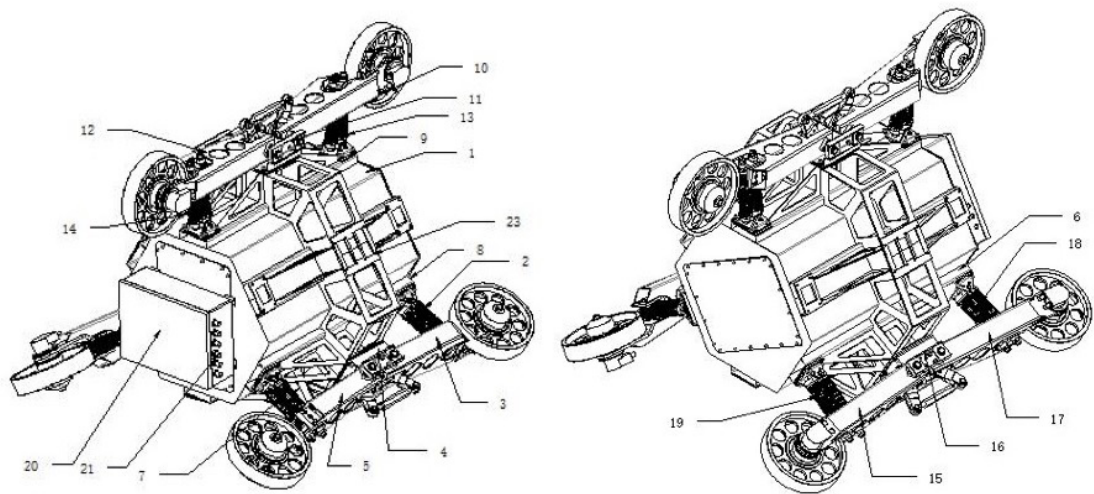
Figure 2. Previous design of oil pipeline inspection robot: (1) power box; (2) spring mechanism No. 1;